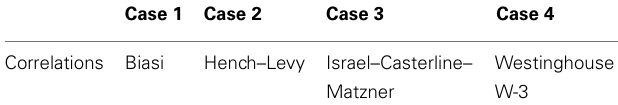
Table 9 | Sensitivity analysis on correlations for CHF .